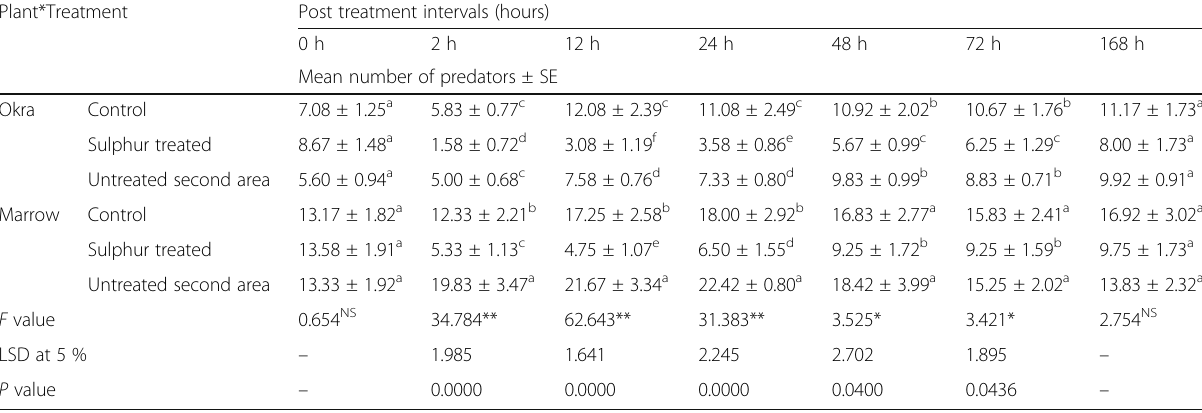
Table 3 Interaction of two factors (Plant*Treatment) with respect to the adult predators ’ abundance